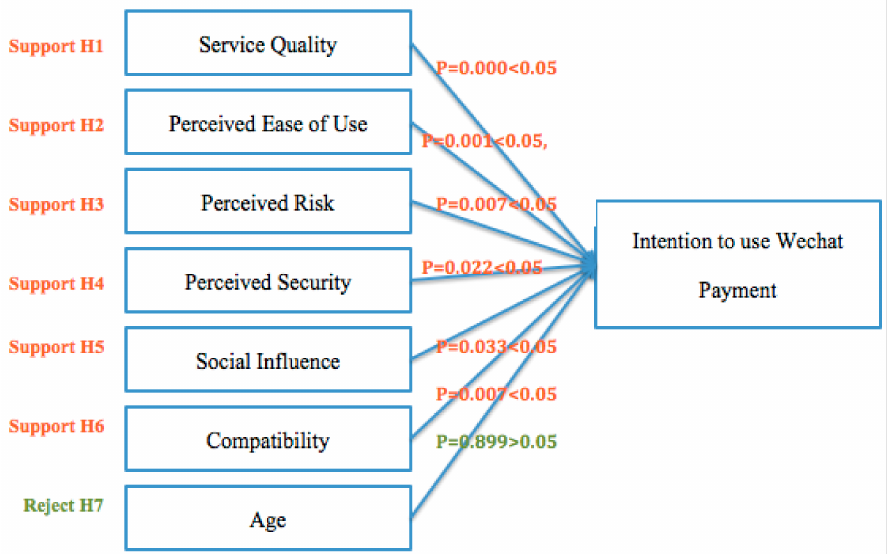
Figure 3. Simplified results of regression